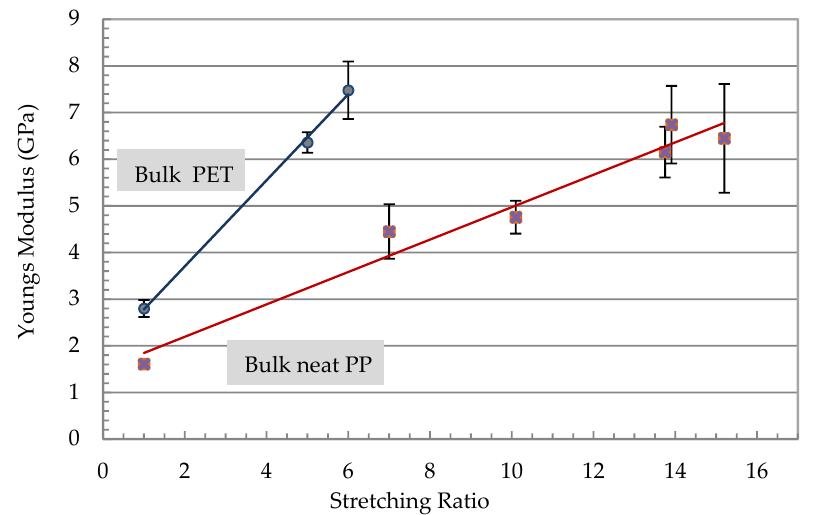
Figure 6. Young's modulus of stretched neat polymer filaments. Figure 6. Young’s modulus of stretched neat polymer